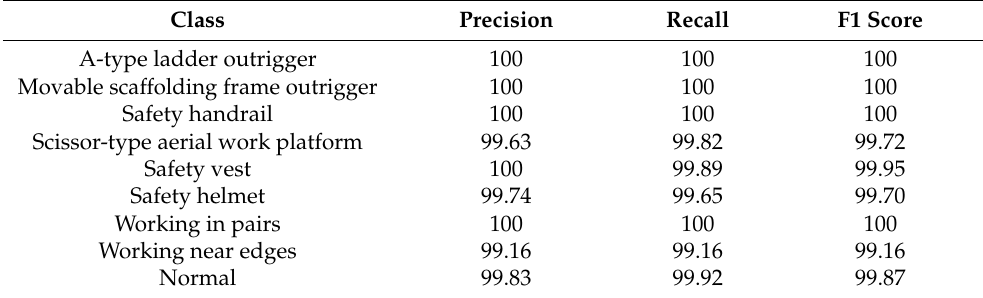
Table 3. Performance by class in